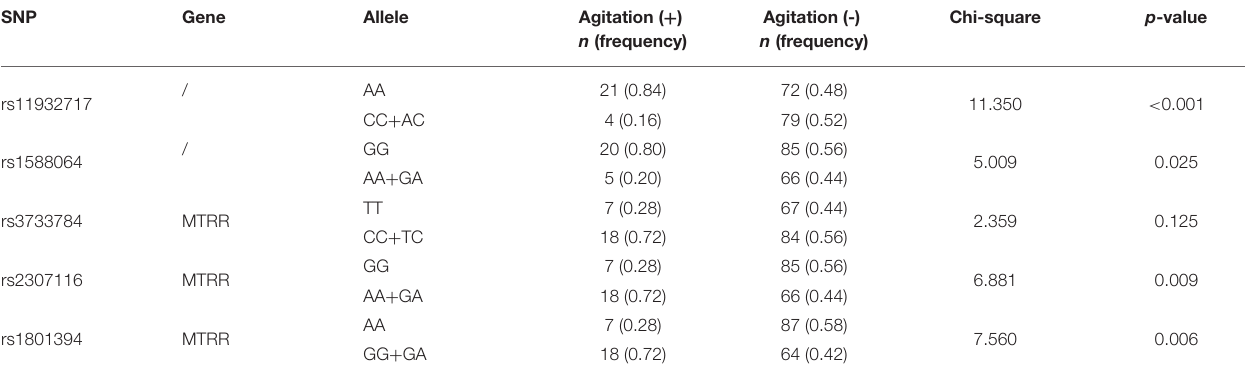
TABLE 3 | Distribution of SNPs associated with the susceptibility to agitation in all included patients ( n =